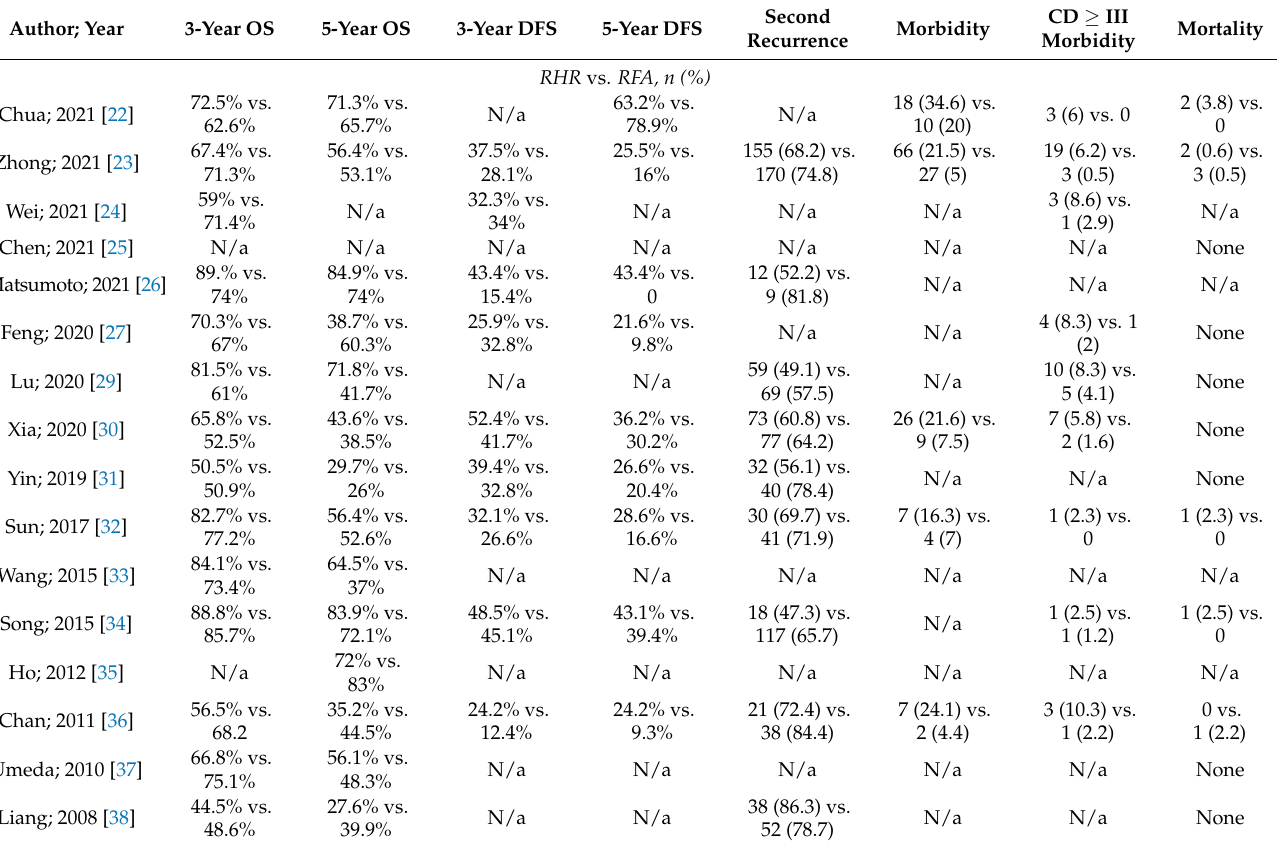
Table 3. Summary of individual study